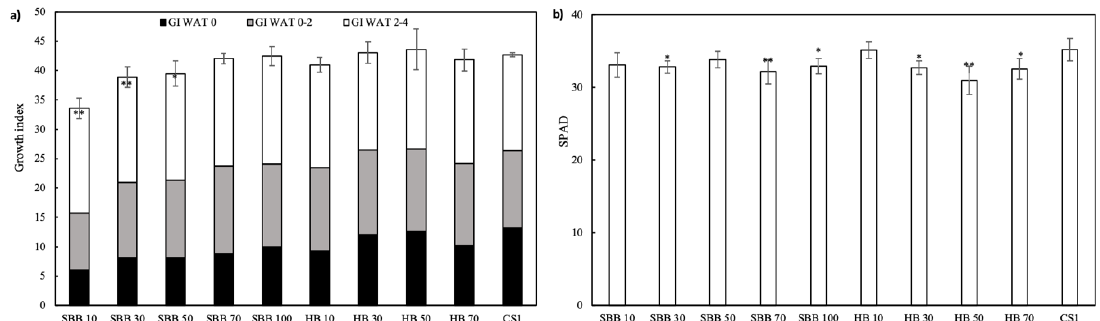
Figure 7. The growth index (a) and SPAD (b) of basil plants transplanted from biochar-amended mixes after four weeks. SBB = sugarcane bagasse biochar; HB = mixed hardwood bioTA CS1 = commercial growing substrate. SBB (10%, 30%, 50%, 70% and 100%; by vol.) incorporated with 30% perlite with the rest being peat moss; HB (10%, 30%, 50% and 70%; by vol.) incorporated with peat moss. (*, ** indicate a significant di ff erence from the control using Dunnett’s test at p ≤ 0.05 and p ≤ 0.01, respectively). Table 5. Biomass of basil plants transplanted from biochar-amended mixes after four weeks. (*, ** indicate a significant di ff erence from the control using Dunnett’s test at p ≤ 0.05 and p ≤ 0.01, respectively).